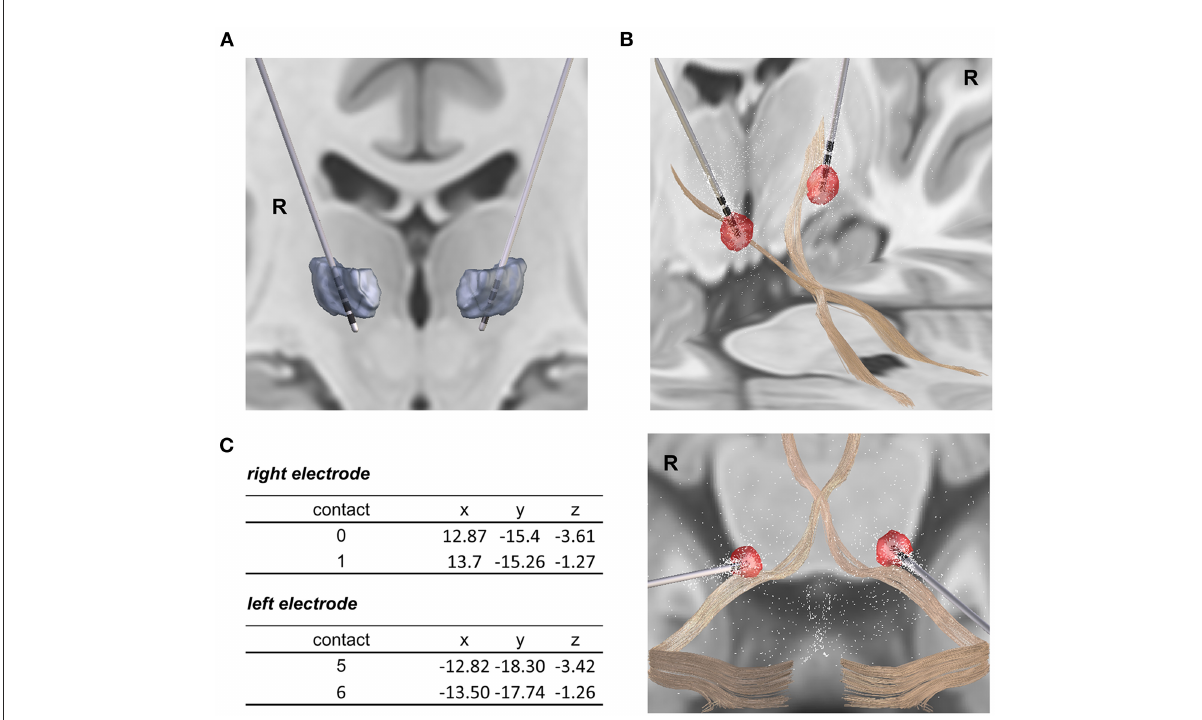
FIGURE3 Reconstruction of DBS electrode placement. (A) Electrode placement in the VIM with the lowest contacts (0, 5) reaching beyond the thalamus border. (B) Topographic vicinity of the dentato-thalamic tract (DTT) and the volume of tissue activated (VTA) during low-frequency stimulation of the lowest contacts (30Hz, 4mA). The electrode position in relation to the DTT is shown from both a lateral and a superior perspective. The right side of the patient is marked with “R”. (C) Electrode placement and MNI coordinates of the active contacts for the high-frequency stimulation programme (contacts 1, 6: 3.5mA, 30Hz, 60 µ s) and the low-frequency stimulation programme (contacts 0, 5: 4mA, 30Hz, 60 µ s) are displayed. Electrode placement was reconstructed by co-registration of preoperative MRI and postoperative CT images and normalization into the MNI_ICBM_2009b_NLIN_ASYM space and anatomic atlases using the Lead-DBS